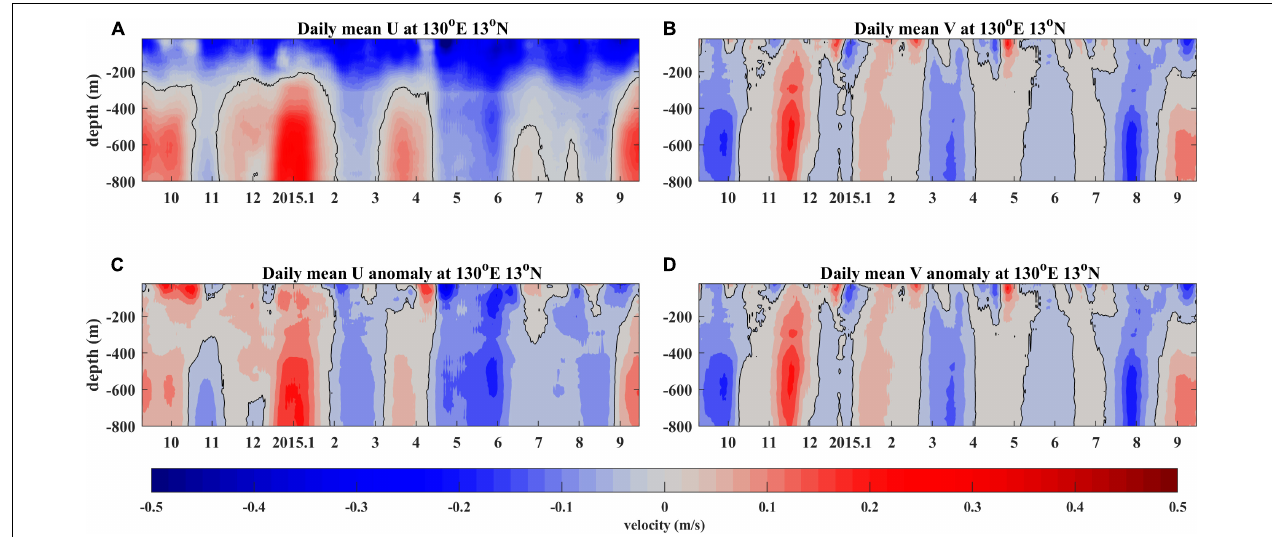
FIGURE 2 | Daily mean velocities (A,B) and their anomalies (C,D) measured by the ADCP mooring at 13 ◦ N, 130 ◦